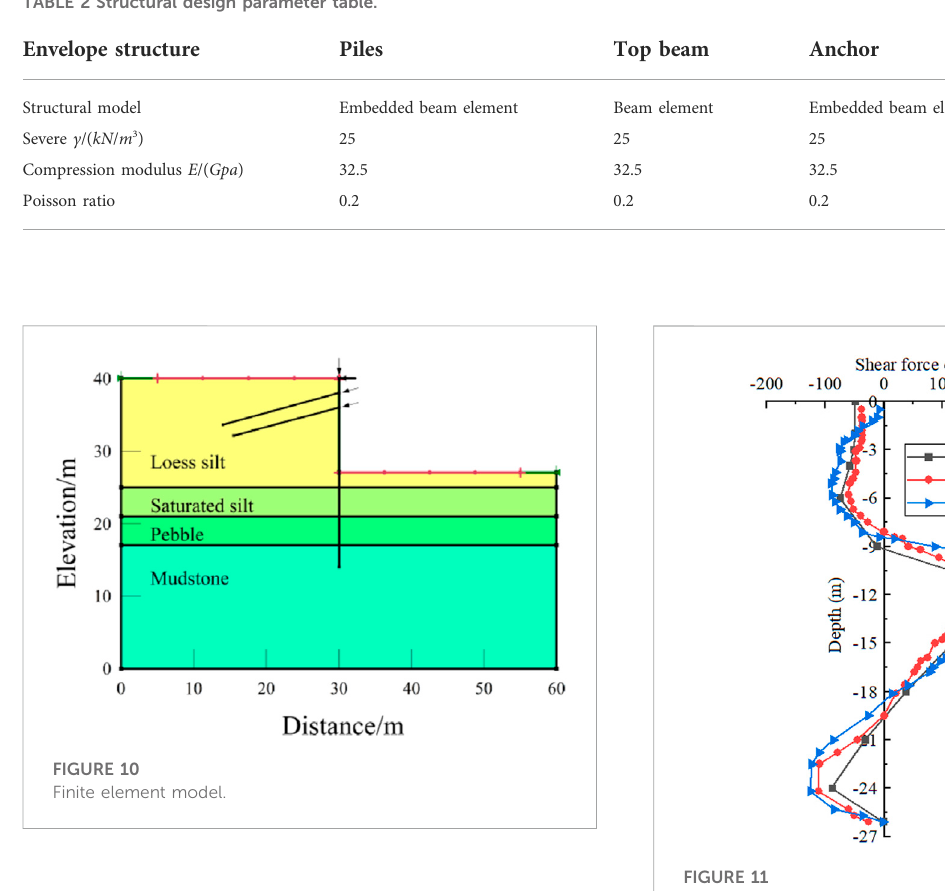
FIGURE 11 Pile shear force comparison